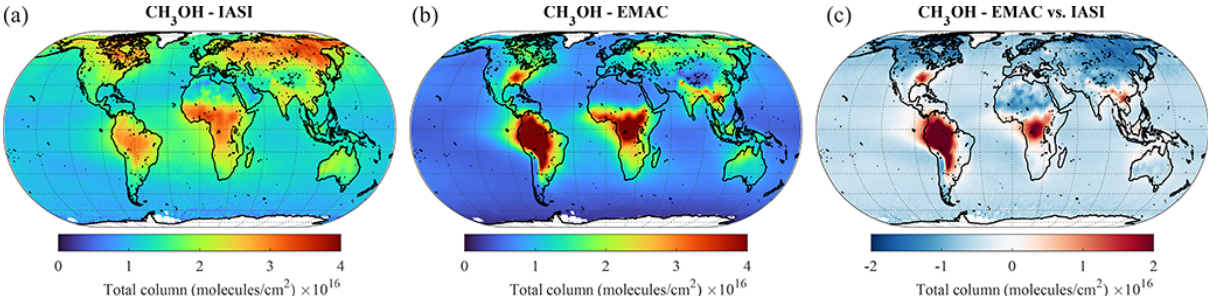
Figure 8. Annually averaged CH 3 OH total column densities (inmolec . cm − 2 ) from IASI satellite observations (a) and simulated by EMAC (b) and the EMAC-to-IASI column density differences (c) for the year 2010.